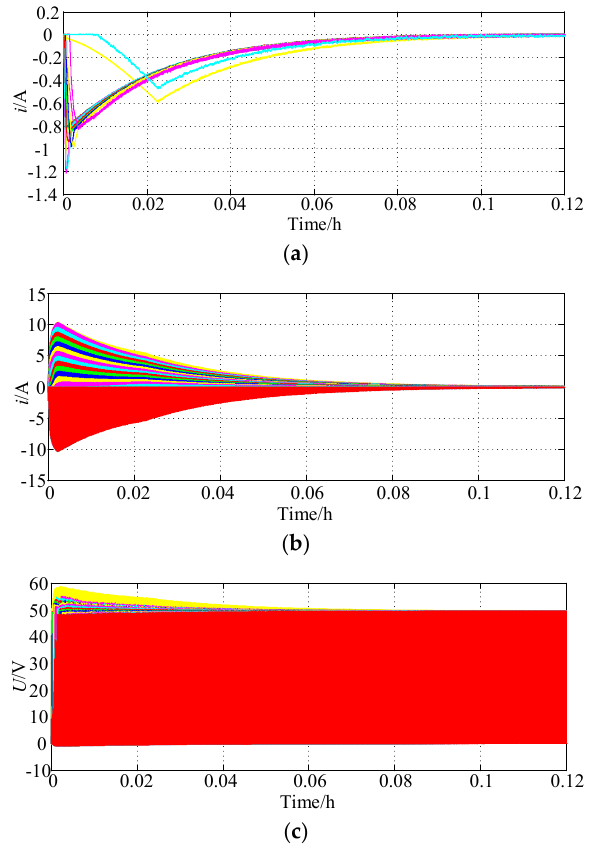
Figure 11. Key waveforms of the simplified equalisation scheme in the discharging process of U 1 . ( a ) The current of L 1 and the driving signal of S 1 . ( b ) The current of L 1 , U 2 , U 3 , and U 4 . (c) voltage of the switches